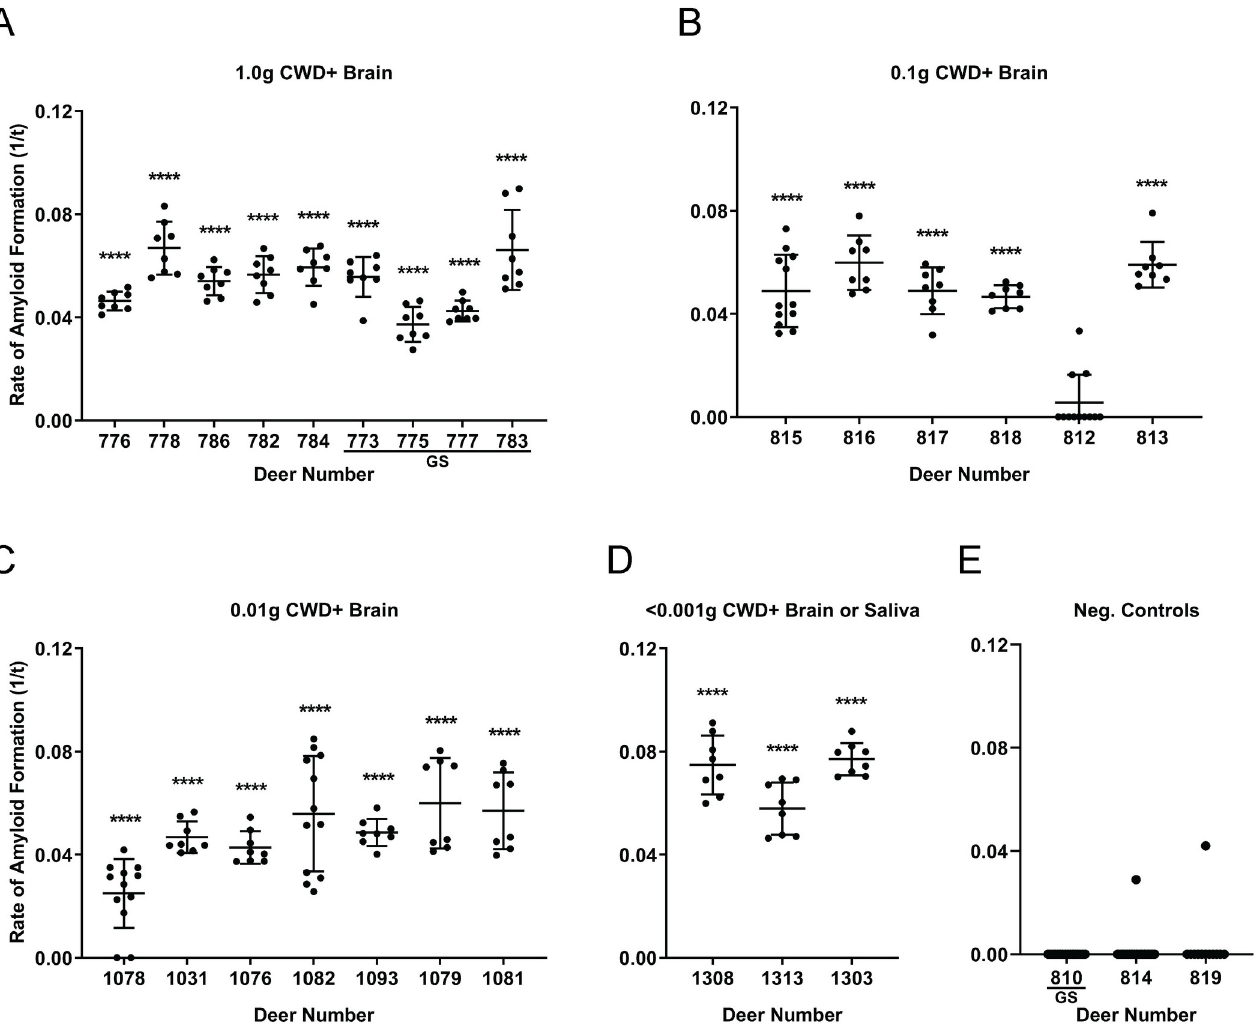
Fig 1. Detection of PrP CWD in third eyelids of symptomatic deer by RT-QuIC. (A) RT-QuIC analysis of third eyelid samples collected from 96GG and 96GS WTD inoculated with 1.0g of CWD-positive deer brain by oral administration ( per os) . Statistically significant amyloid seeding activity was detected in the third eyelids of all the deer in this cohort ( ���� p < 0.0001, two-tailed Mann-Whitney test) when compared with respective negative control tissues. (B) RT-QuIC analysis of third eyelid samples collected from 96GG WTD inoculated with 0.1g of CWD-positive deer brain via aerosolization. 5 of 6 third eyelids displayed significant amyloid seeding activity ( ���� p < 0.0001, two-tailed Mann-Whitney test) when compared with respective negative control tissues. (C) RT-QuIC analysis of third eyelid samples collected from 96GG WTD inoculated with 0.01g of CWD-positive deer brain per os . 3 of 3 third eyelids displayed significant amyloid seeding activity ( ���� p < 0.0001, two-tailed Mann-Whitney test) when compared with respective negative control tissues. (D) RT-QuIC analysis of third eyelid samples collected from 96GG WTD inoculated with 300ng-0.001g of brain or saliva per os respectively. (E) RT-QuIC analysis of third eyelid sample controls collected from one 96GS and two 96GG WTD inoculated with 0.1g of CWD-negative deer brain via aerosolization for negative controls. Each third eyelid sample is represented by the mean and standard deviation from at least eight